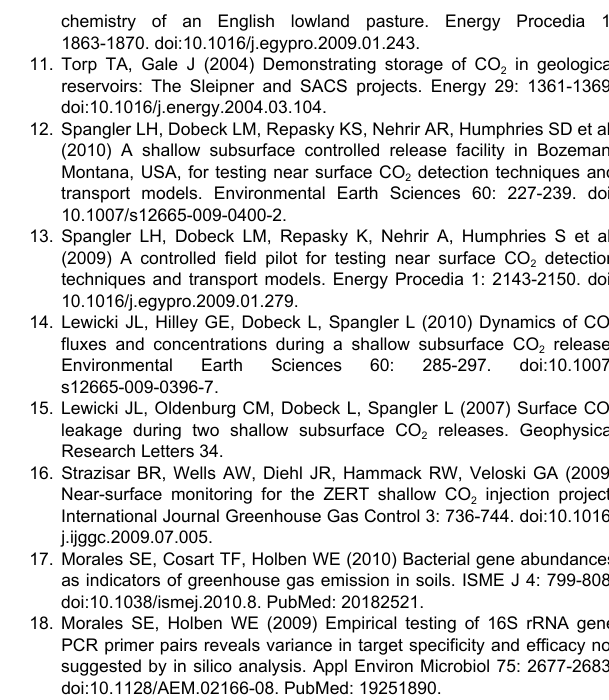
Table S1. Primers and PCR conditions used in this study. (TIF) Table S2. Details for statistical analyses based comparison of target abundance in response to CO Table 1.